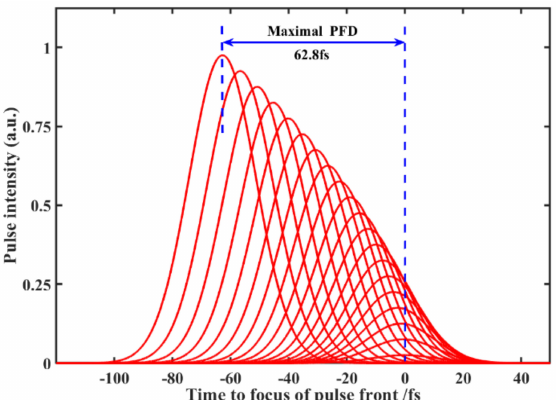
Figure 5. Temporal intensity distribution at focus of the 200 TW